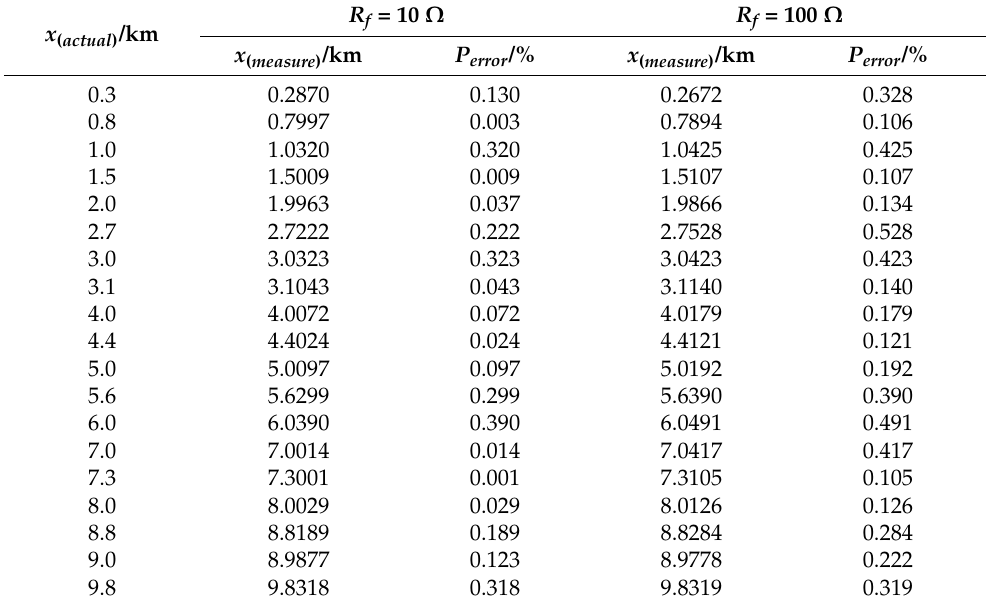
Table A1. Fault location results and errors with transition resistors.